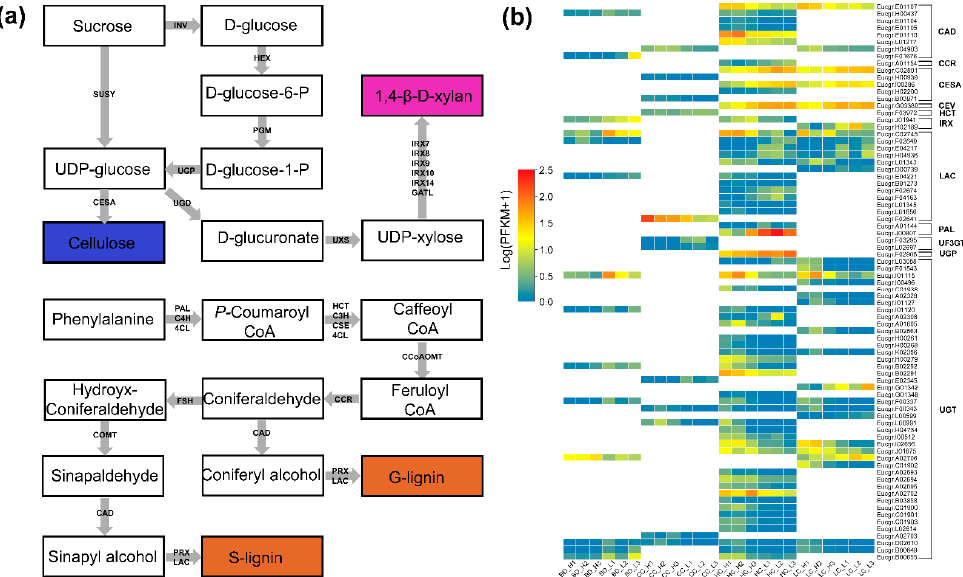
Figure 5. ( a ) Major biosynthesis pathway for cellulose, xylan, and lignin [15]. ( b ) Transcription of 79